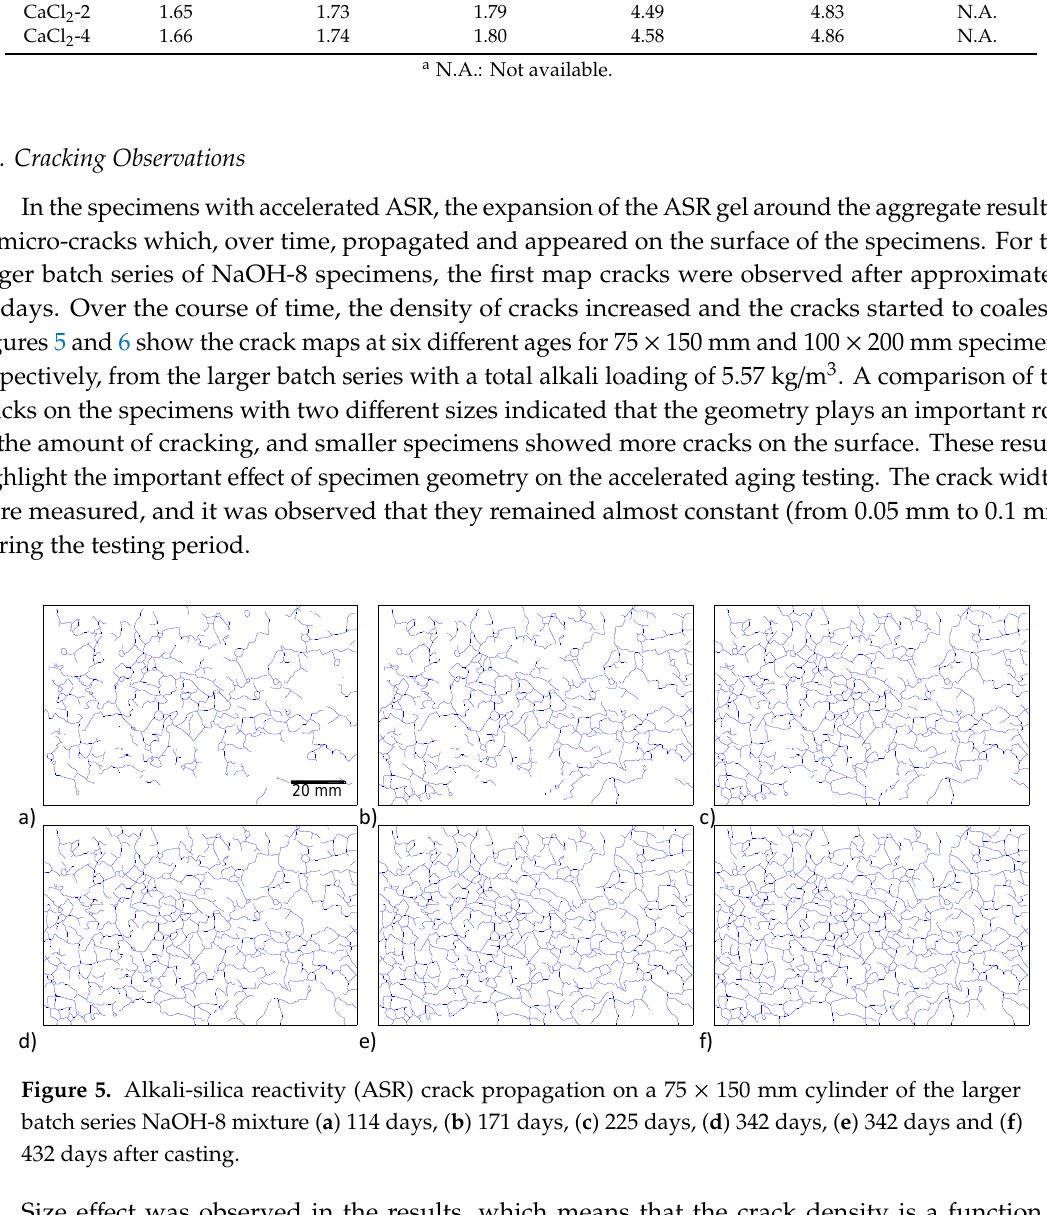
Figure 5. Alkali-silica reactivity (ASR) crack propagation on a 75 × 150 mm cylinder of the larger batch series NaOH-8 mixture ( a ) 114 days, ( b ) 171 days, ( c ) 225 days, ( d ) 342 days, ( e ) 342 days and ( f ) 432 days after casting.